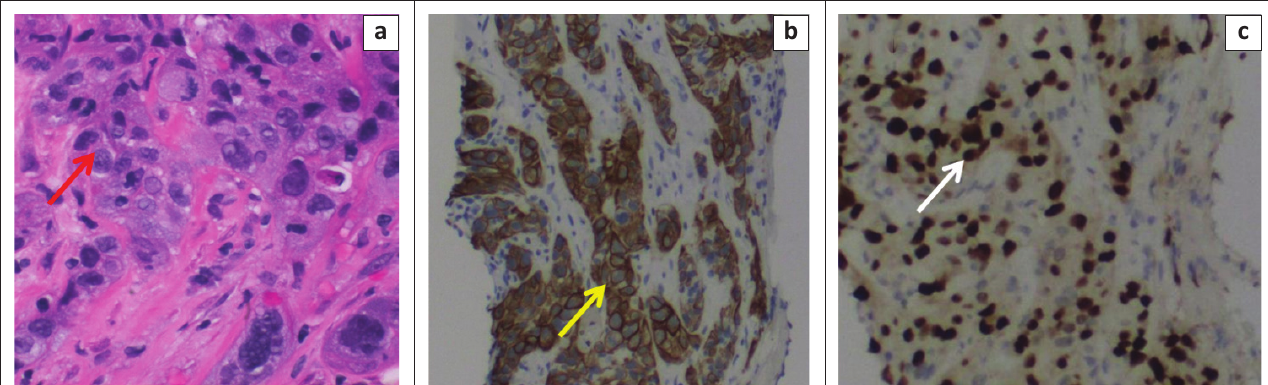
FIG URE 3: Histopathological diagnosis of primary squamous cell carcinoma of the urinary bladder (a) Hematoxylin and eosin stain; 400 × magnification indicating well differentiated squamous cells (red arrow). (b) The Ck-7 stain is positive (yellow arrow). (c) The P40 stain is also positive in the tumour cells (white arrow). The histopathology confirms the diagnosis of primary squamous cell carcinoma of the urinary